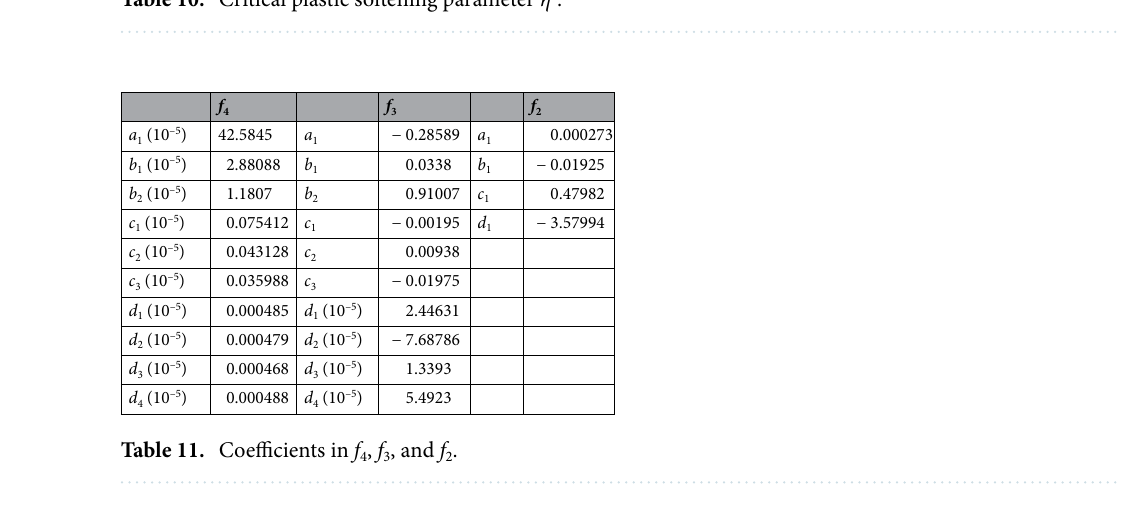
Table 10. Critical plastic softening parameter η * .